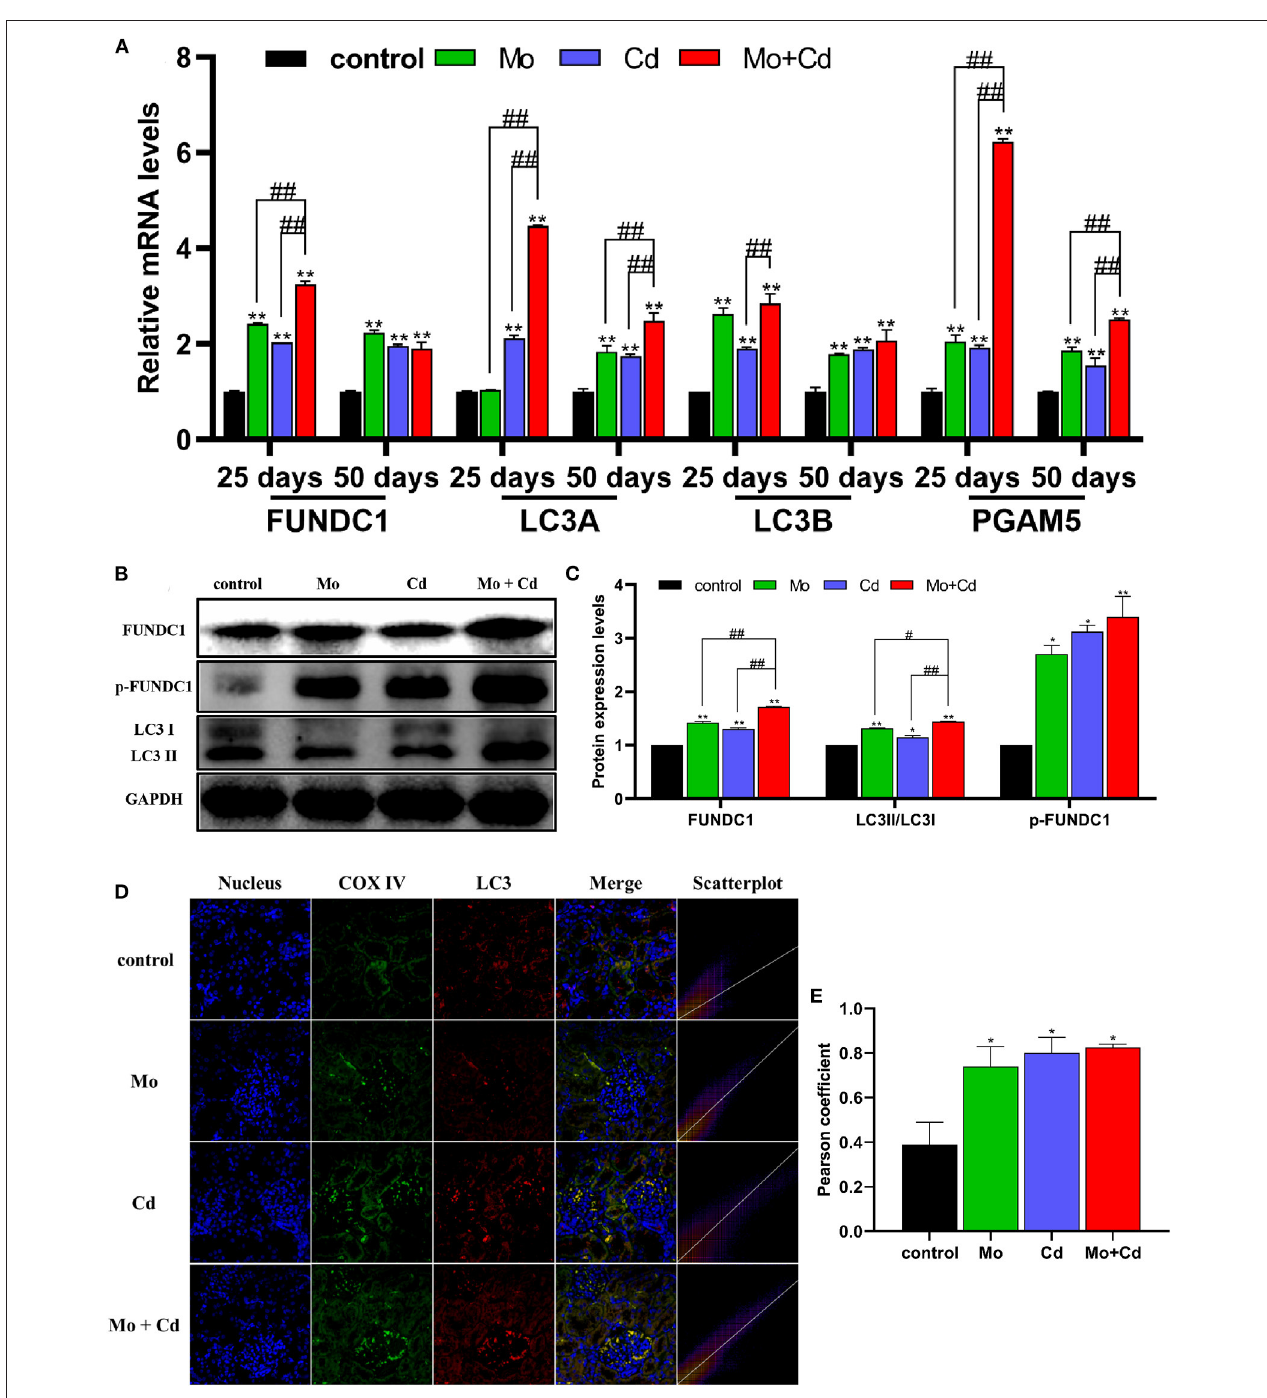
FIGURE 6 | Effects of Mo and/or Cd on immunofluorescence of LC3, mitophagy-related mRNA and protein expression levels. (A) The mRNA levels of FUNDC1, LC3A, LC3B and PGAM5. (B) The western blot results of FUNDC1, p-FUNDC1 and LC3. (C) The quantification of FUNDC1, p-FUNDC1 (Ser17) and LC3II/LC3I protein levels. (D) Immunofluorescence co-location of COX IV and LC3 at day 50. In the images, the nucleus staining is shown in blue, COX IV staining is shown in green, LC3 staining is shown in red, and the signals of colocalization are shown in merged images. (E) Pearson coefficient of the colocalization of COX IV and LC3. Data are expressed as means ± SD ( n = 6). “*” indicates significant difference compared to the corresponding control (* P < 0.05, ** P < 0.01). “#” indicates statistically significant difference between corresponding groups ( # P < 0.05, ## P <